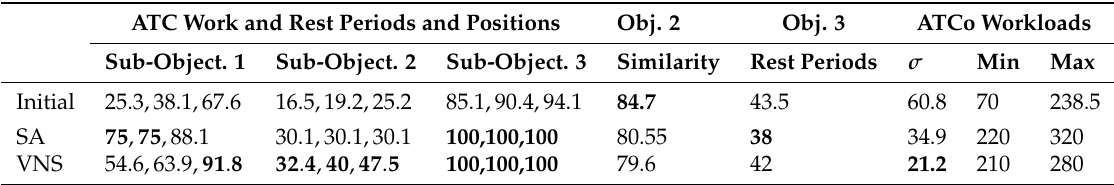
Table 6. Objective functions in the initial solution and solutions reached by SA and VNS for Instance 4. ATC Work and Rest Periods and Positions Obj. 2 Obj. 3 ATCo Workloads Sub-Object.